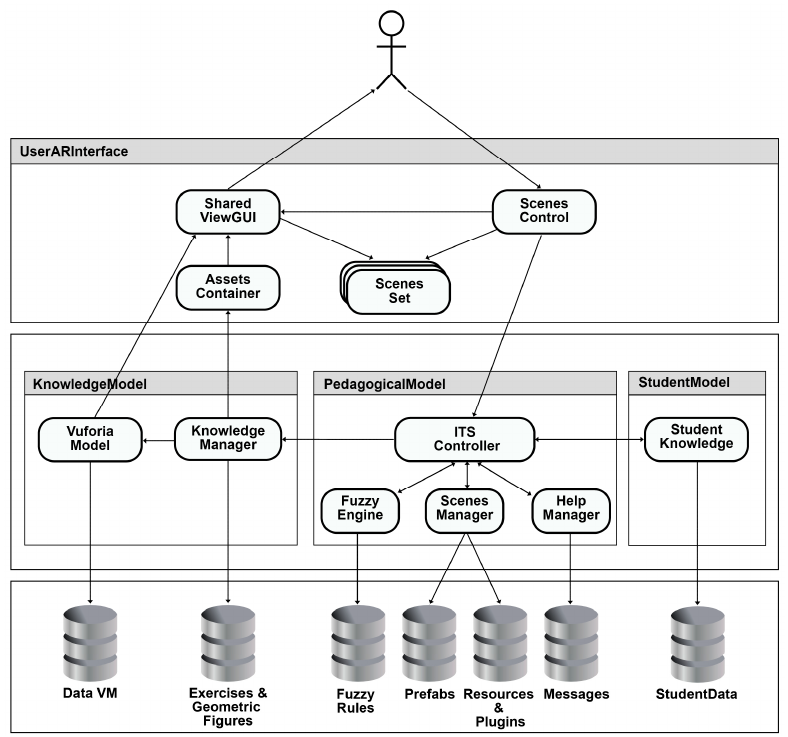
Figure 1. ARGeoITS architecture.